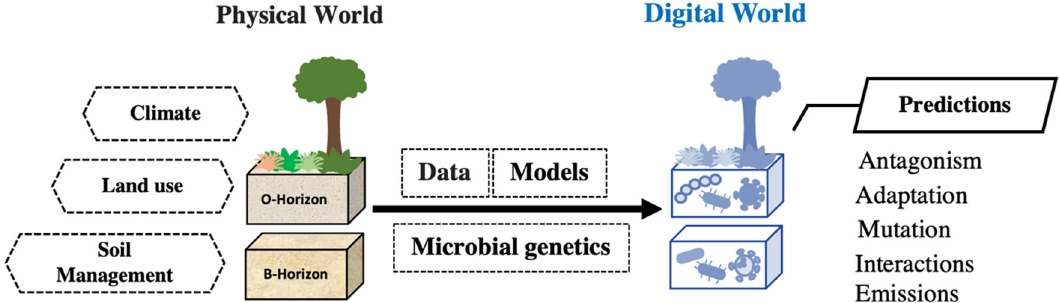
Figure 1. A conceptual framework for digital twins of soil microbiome.